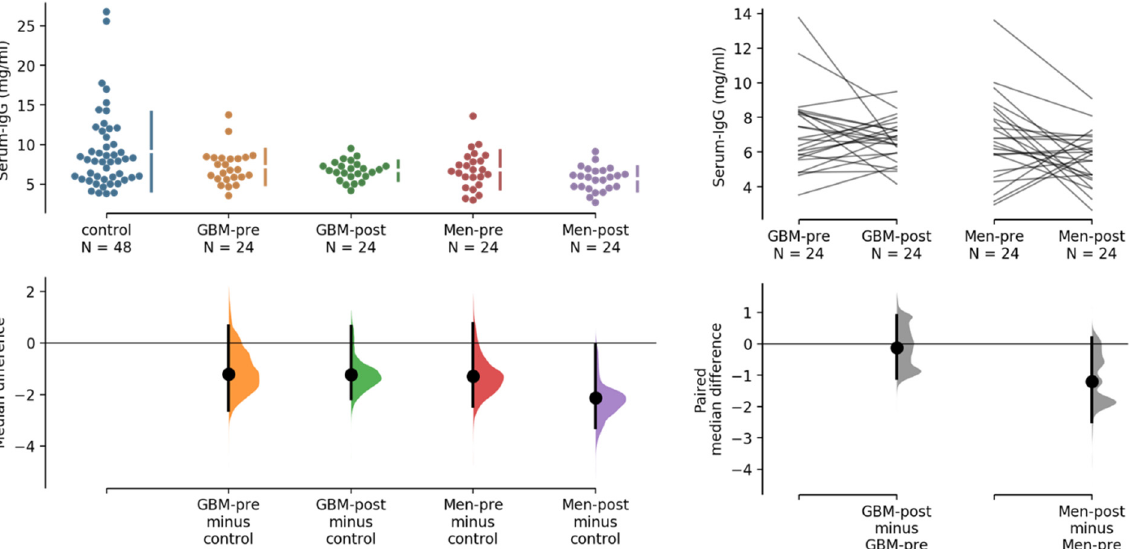
Figure 2. Comparative analysis of serum IgG concentrations in 144 samples, using healthy control sera as common control (left), and pairwise analysis of GBM and MEN samples before and after surgery. The serum IgG concentrations are indicated on the y-axes in the upper panels, the mean differences in the lower panels. For 110 of these samples, antibody profiling on 16 k protein array data (as shown in Figure 1) were available.